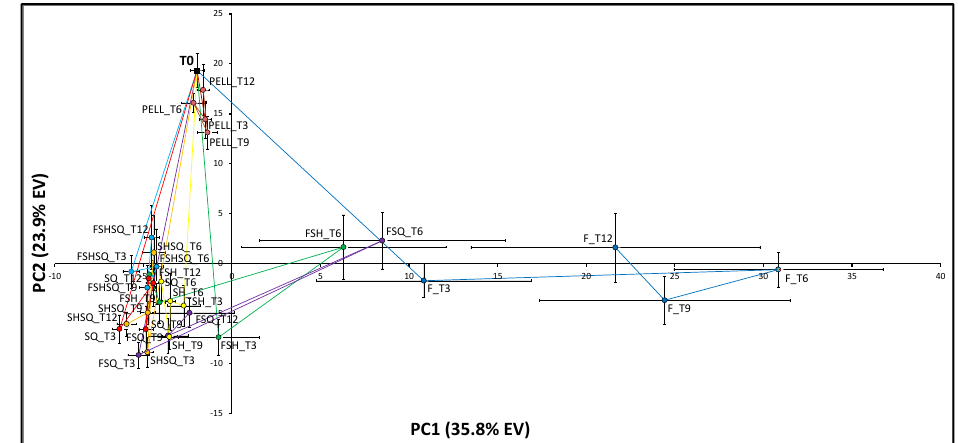
Figure 5. Unsupervised PCA score plot (mean ± SEM) from red drum liver tissue extracts for the 8 diets at 5 different time points (T0, T3, T6, T9, T12) over the course of the 12-week red drum feeding trial. The explained variances along PC1 and PC2 are shown in brackets. For each time point, the mean scores are indicated with circles or a square (T0); SEM error bars are displayed both in PC1 and PC2 for each time point. T0, initial time point (conditioning diet, same composition as PELL); F, fish diet; FSH, fish + shrimp diet; FSHSQ, fish + shrimp + squid diet; FSQ, fish + squid diet; PELL, pelleted commercial fishmeal-based diet; SH, shrimp diet; SHSQ, shrimp + squid diet; SQ, squid diet.